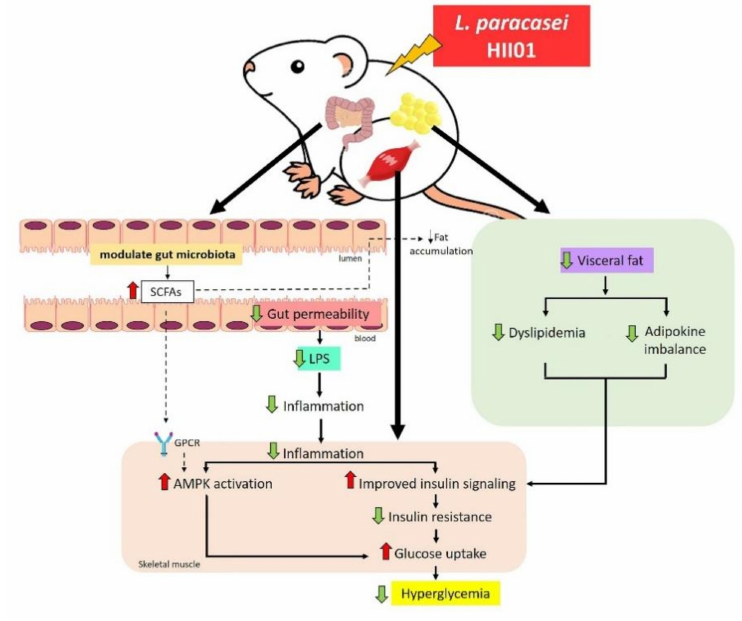
Figure 8. Possible mechanism of L. paracasei HII01 in type 2 diabetic